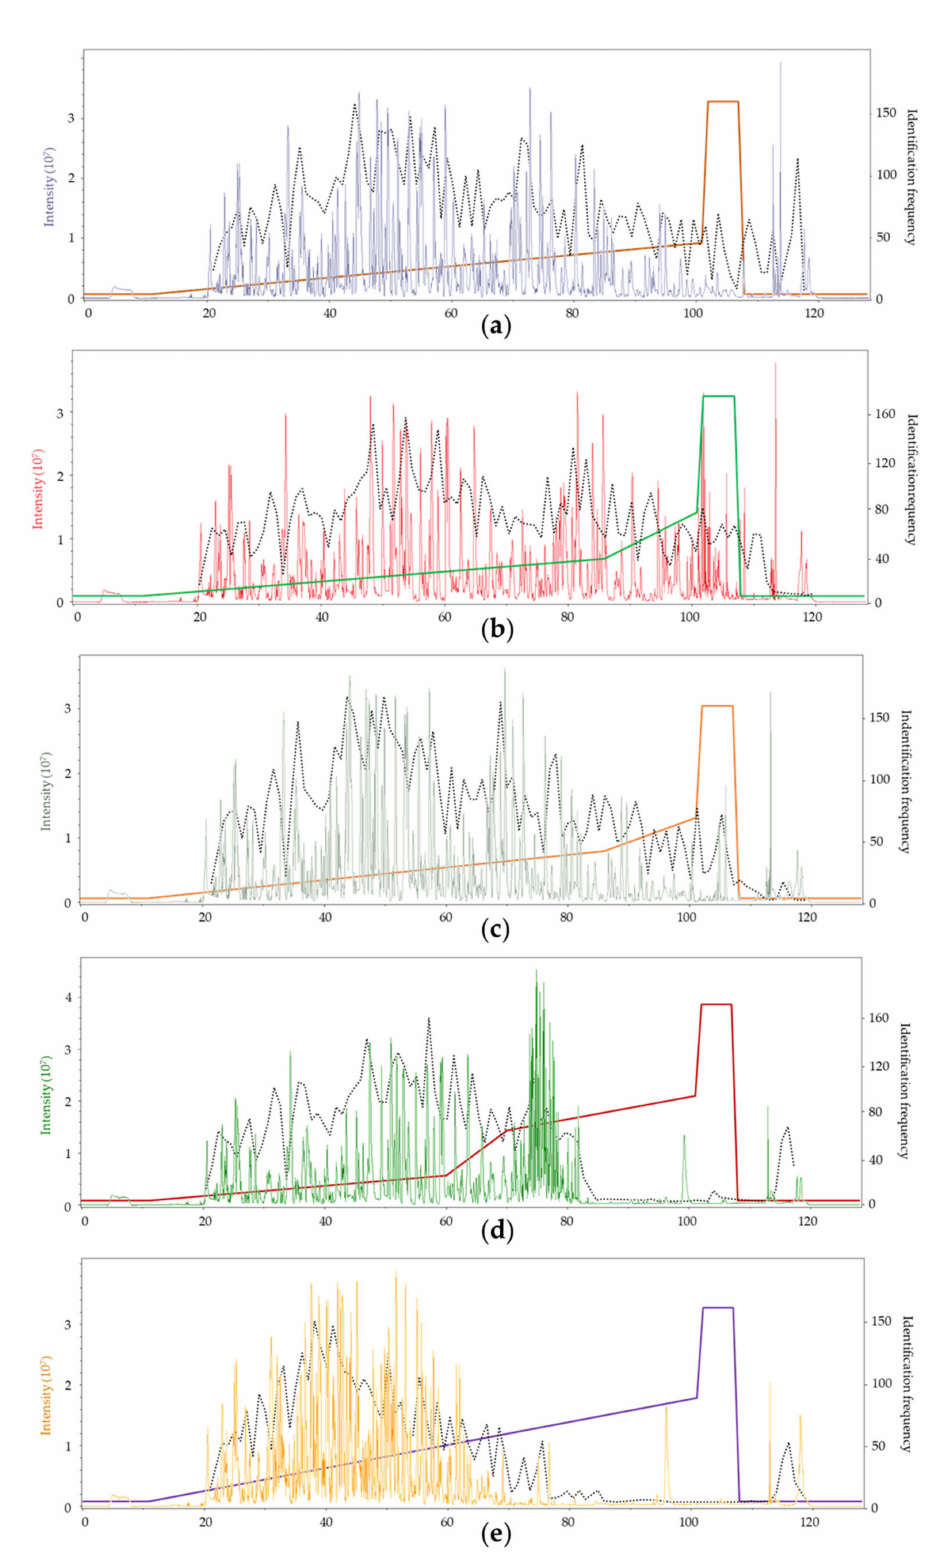
Figure 5. Representative chromatograms and the peptide detection rate (dotted line) obtained with the five different gradients. The gradient slopes are overlaid in the background (without a corresponding